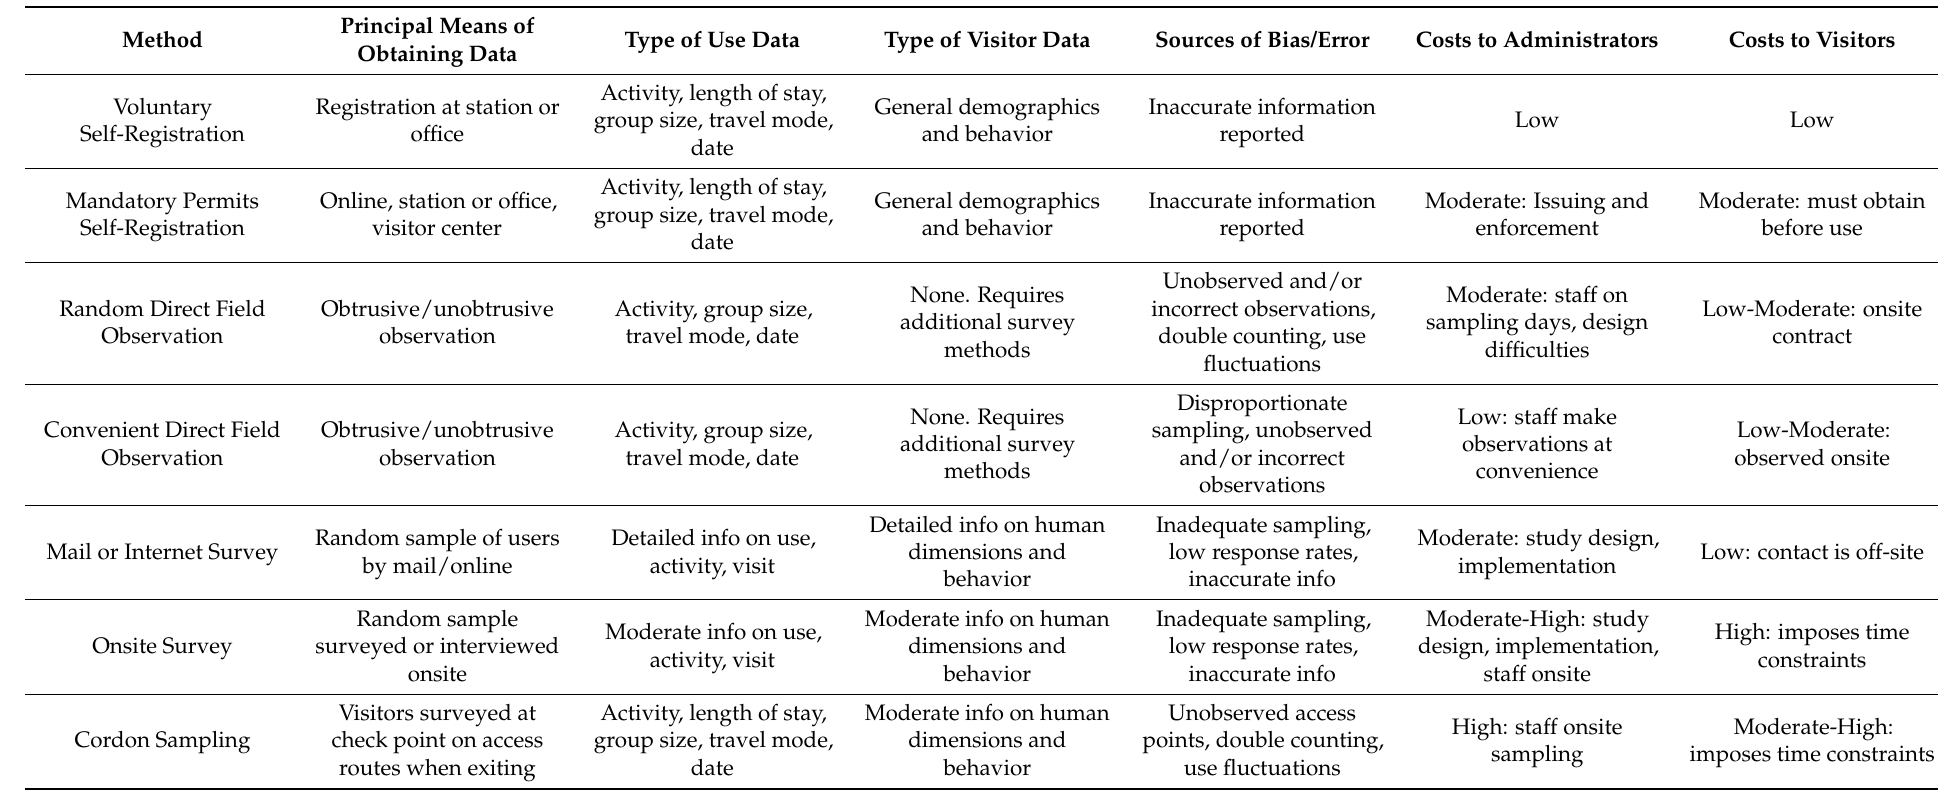
Table 1. Reviewed visitor monitoring methods as applicable to aquatic protected areas. Categories should be weighed for comparison as they relate to the context of the aquatic area that requires visitor monitoring. Methods vary from simple to complex. Means of obtaining data may be variable, depending on the chosen method. Types of use and visitor data should be defined by the protected area and prioritized for management activities. Sources of bias/error should be minimized and controlled for as much as possible in visitation monitoring plans. Costs to administrators may be related to the budget, time, personnel, application, and data processing/validity. Costs to visitors may include imposition on the visitor experience, time constraints, and privacy concerns related to data collection methods. Category criteria should be weighted in any decisions that lead to a full monitoring plan, as certain criteria may hold a higher weight than others in specific site